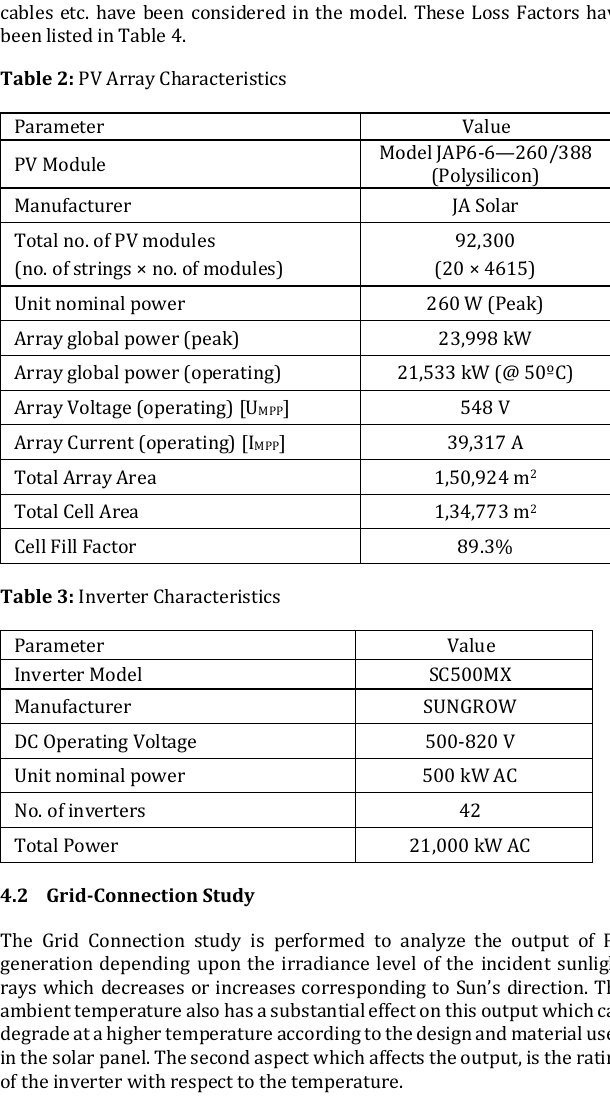
Table 2. The Inverter considered in the